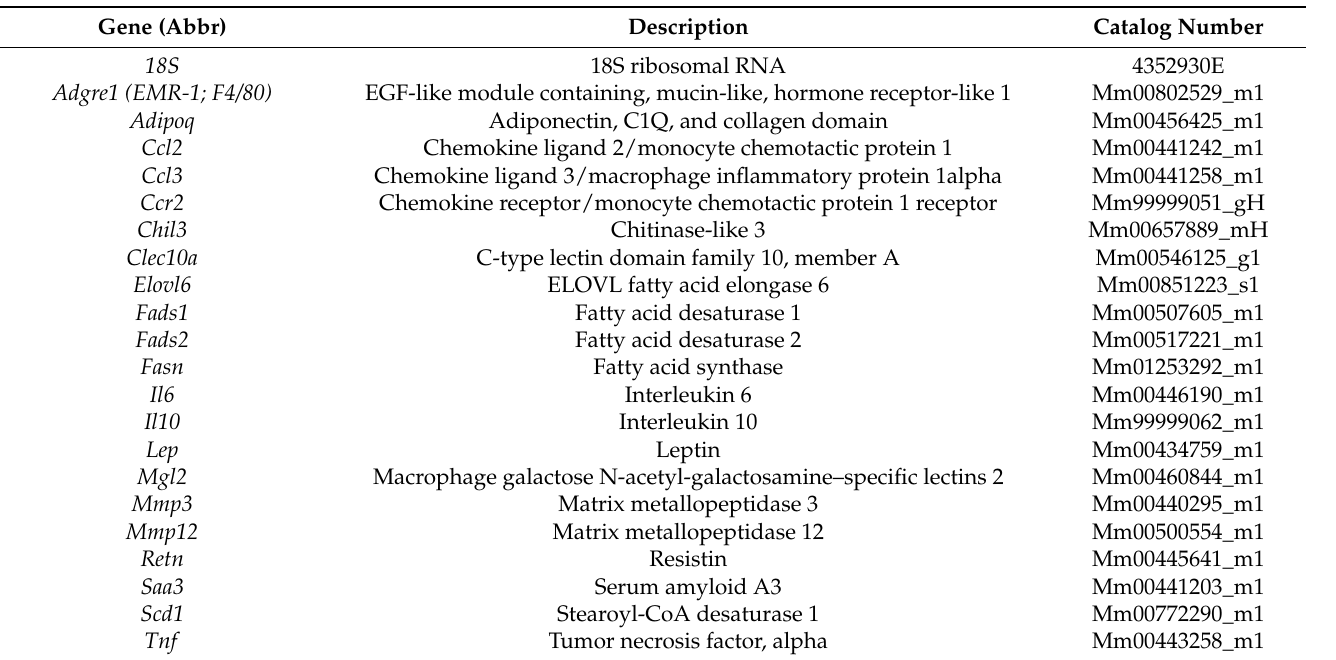
Table 2. Primers used in the